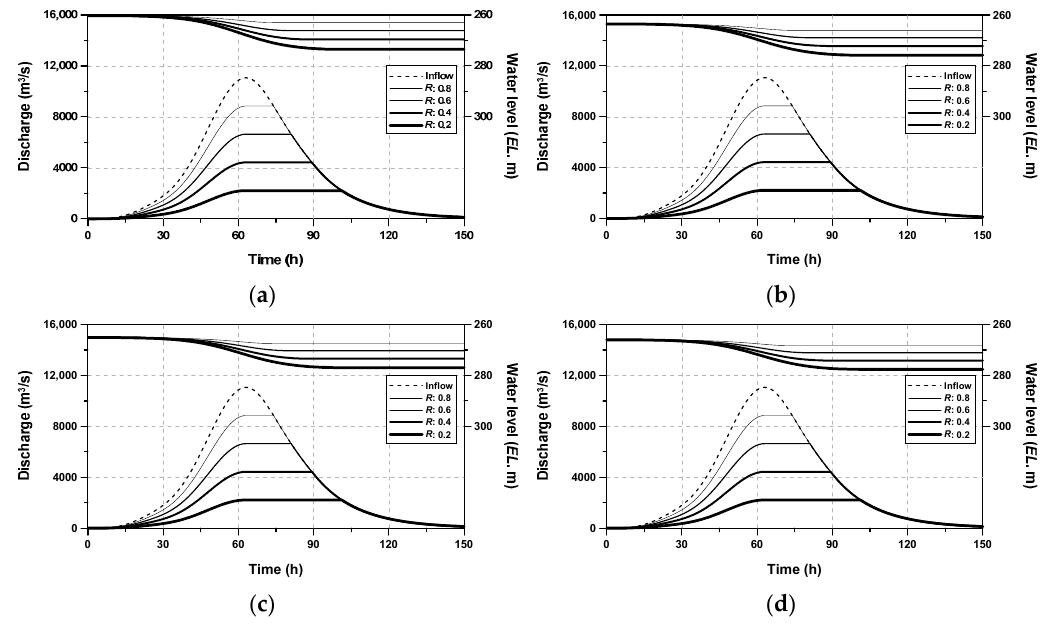
Figure 6. Comparison of dam operation results (discharge and water level) with different C/F ratios and constant rates of the Rigid ROM. ( a ) C/F = 3 (RWL: EL. 260.9 m); ( b ) C/F = 5 (RWL: EL. 264.2 m); ( c ) C/F = 7 (RWL: EL. 265.6 m); ( d ) C/F = 9 (RWL: EL. 266.4 m).